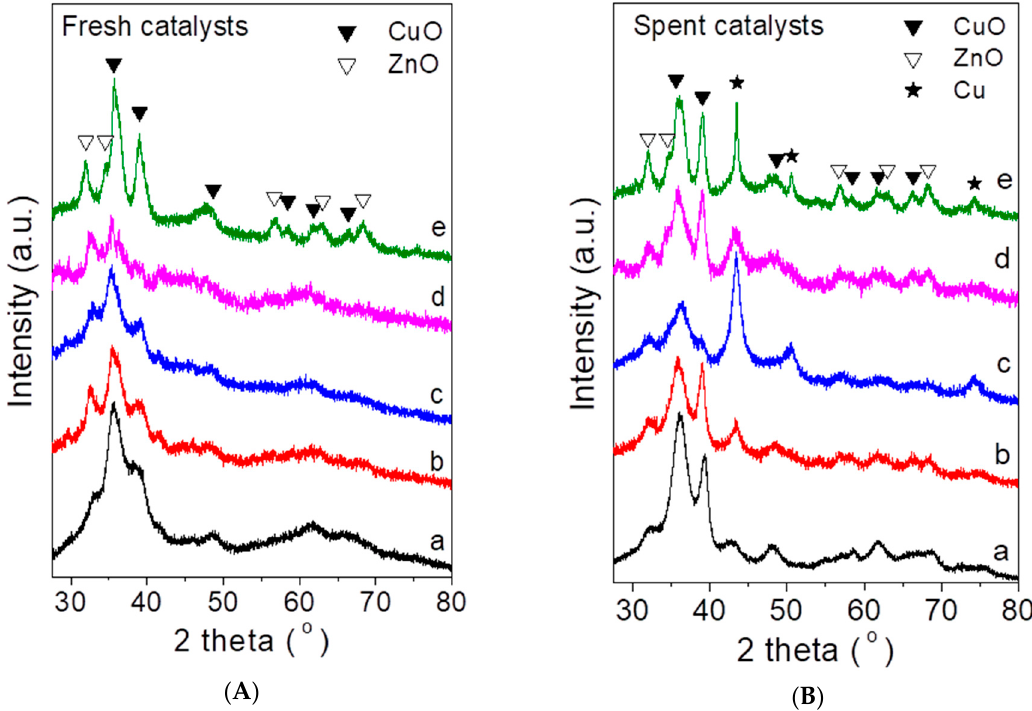
Figure 1. XRD patterns obtained for ( A ) the freshly prepared and ( B ) the spent CZA-La x catalysts: (a) x = 0; (b) x = 25; (c) x = 50; (d) x = 75; (e) x = 100.